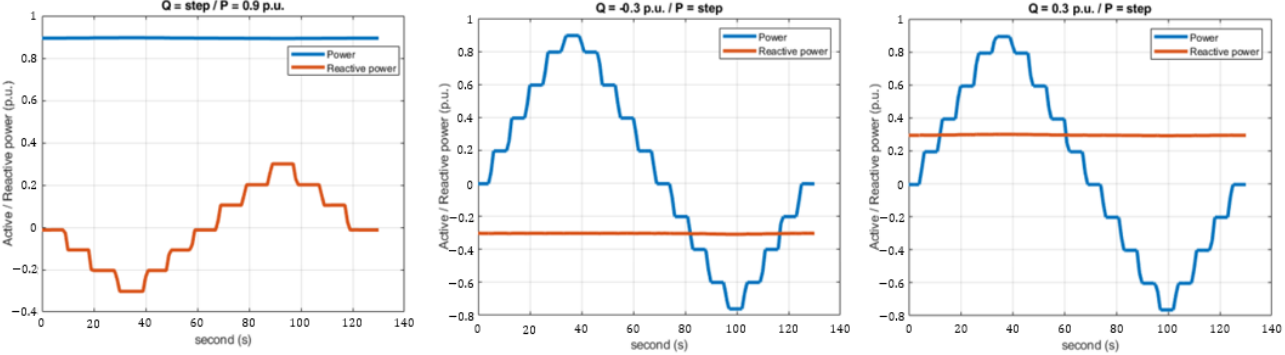
Figure 18. The simulation waveforms for the parameter search. The measurement waveform of the applicability evaluation also included constant active power input and reactive power step output, and active power step output and reactive power fixed input, as shown in Figure 19.